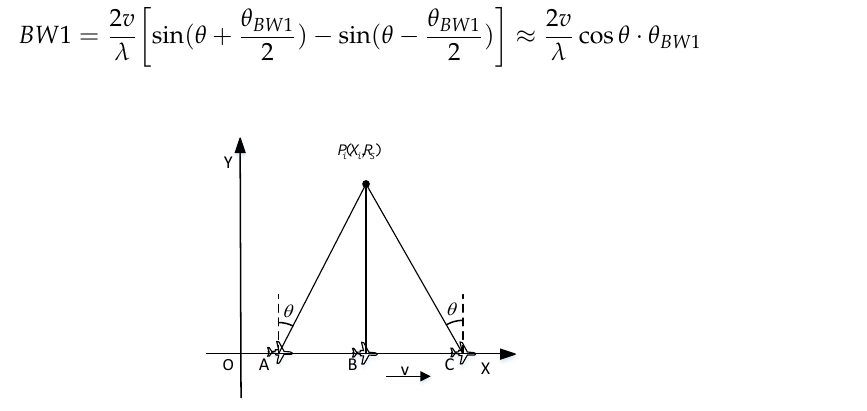
Figure 3. Multi-angle SAR signal model.